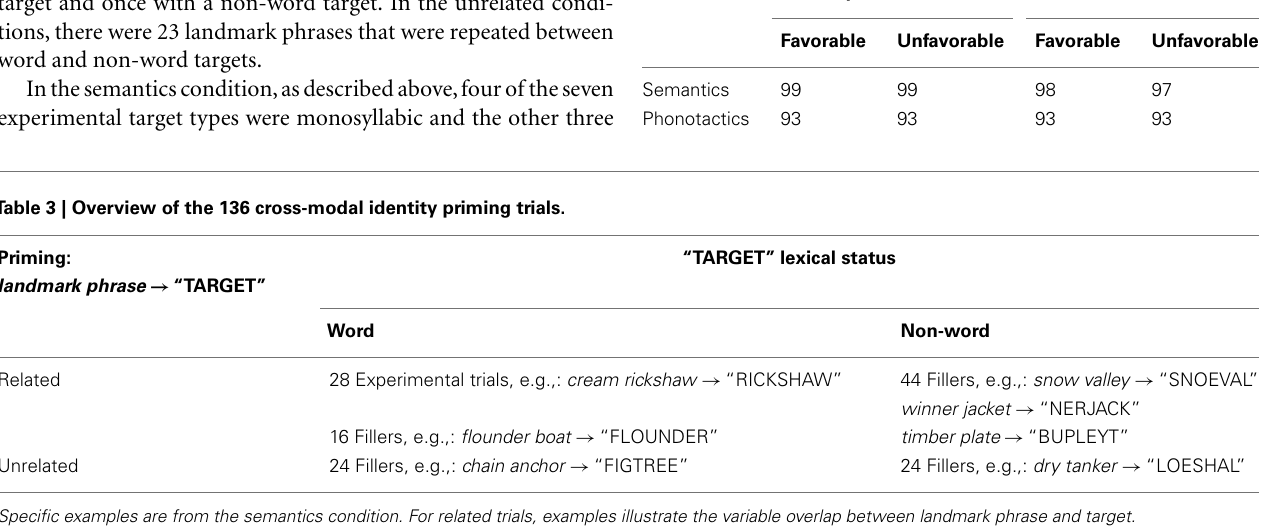
Specific examples are from the semantics condition. For related trials, examples illustrate the variable overlap between landmark phrase and